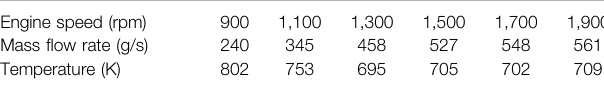
TABLE 1 | ORC inputs as calculated from GT-Power engine